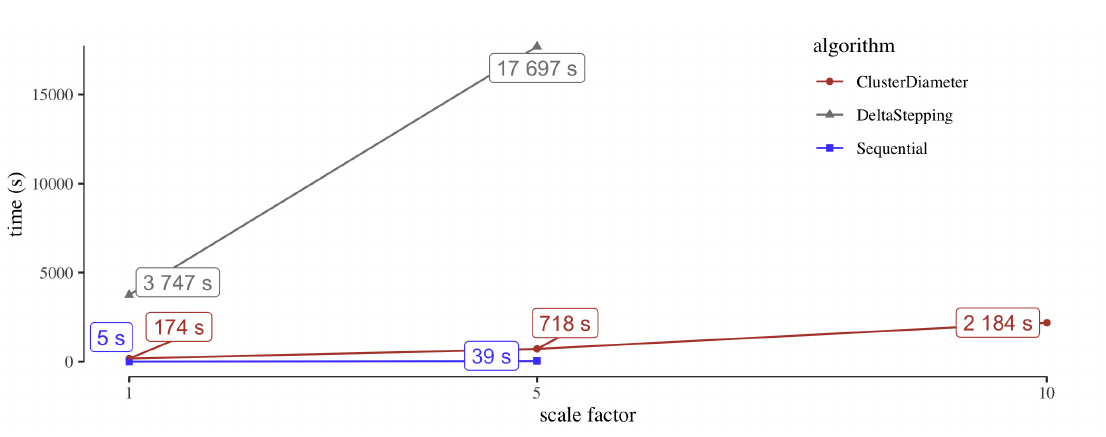
Figure 6. Scalability with respect to the size of the graph for algorithms C LUSTER D IAMETER D ELTA S TEPPING , and a S EQUENTIAL approximation obtained running Dijkstra’s algorithm. The x axis reports the scale of the graph, that is the number of layers used to inflate the original dataset. For USA-x10 (rightmost point), the sequential algorithm could not load the entire graph in memory, whereas D ELTA S TEPPING timed out after five